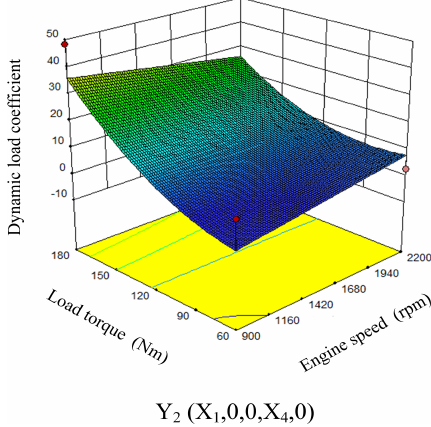
Figure 10. Influence of interaction effect on dynamic load coeffi-